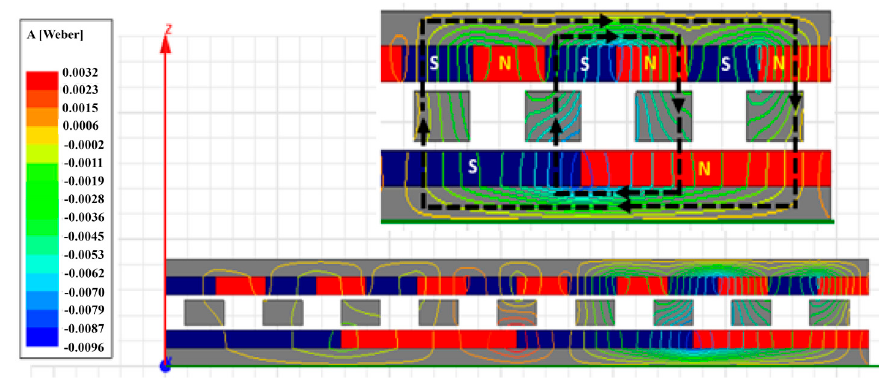
Figure 10. Magnetic flux lines path in a 2D AFMG model.